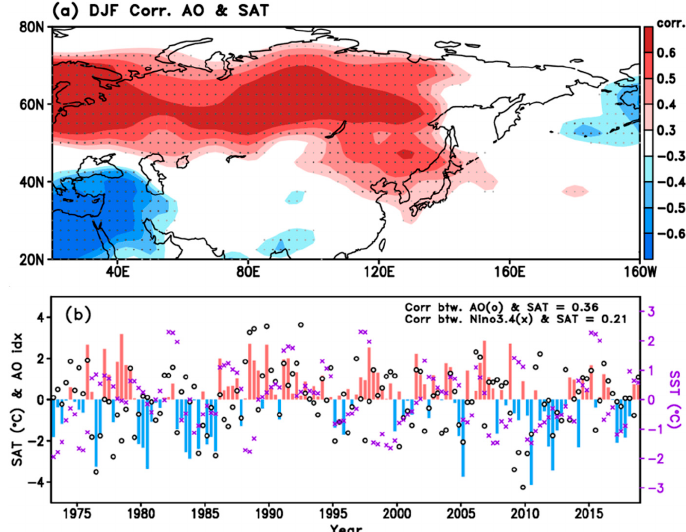
Figure 1. ( a ) Correlation map between Arctic Oscillation (AO) and surface air temperature (SAT) anomalies in wintertime (December to February) during 1973/74–2018/19 and ( b ) Timeseries of observational SAT anomalies in South Korea (Bar). AO (black circle), and El Niño Southern Oscillation (ENSO) index (violet cross mark).